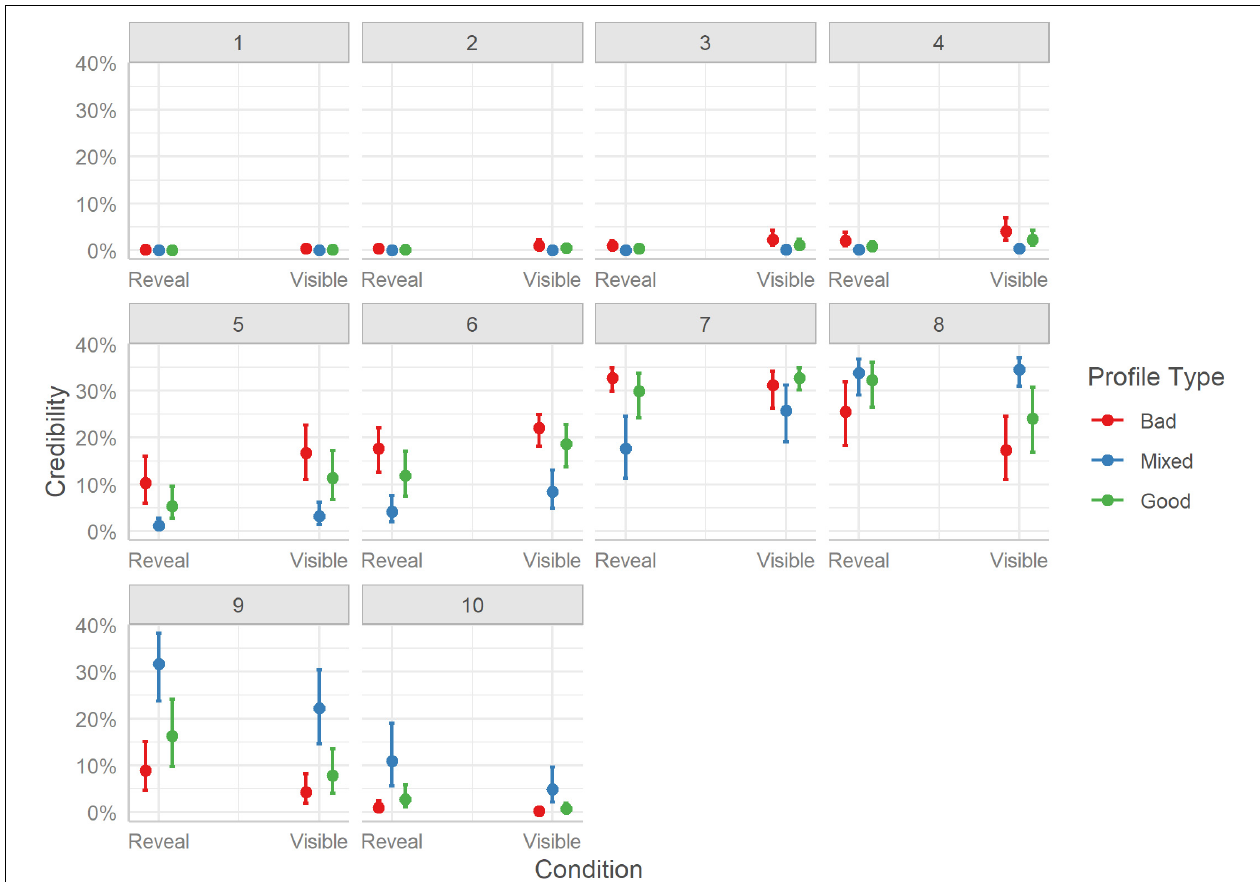
FIGURE 8 | Marginal effects of credibility. The posterior mean estimates of the probability of responses in each of the three Profiles (Bad, Good, Mixed) by the two experimental Conditions (Reveal or Visible). Error bars indicate 95% credible intervals.